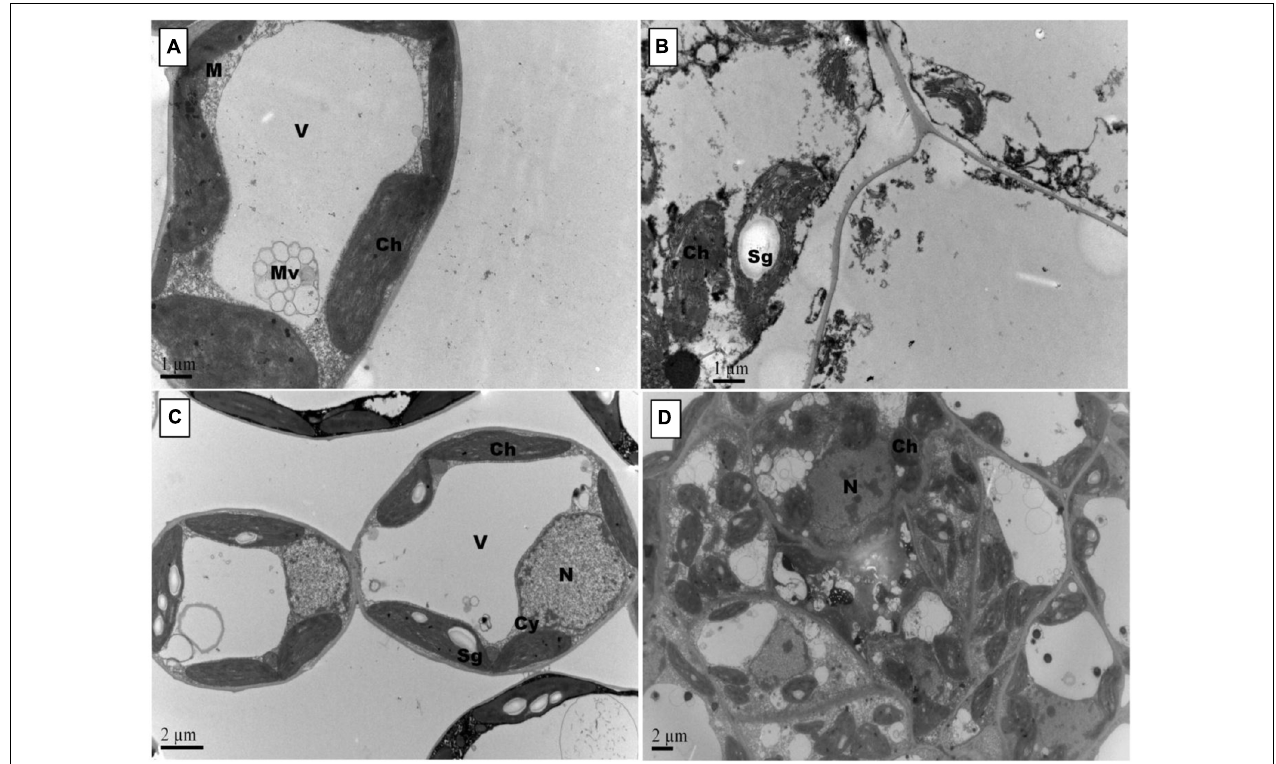
FIGURE 5 | Effects of Pb and GSH on ultrastructure of upland cotton median leaves Transmission electron micrographs represent leaf cell morphology of control (A) , 500 µ M Pb (B) , 50 µ M GSH (C) and 500 µ M Pb + 50 µ M GSH (D) in cotton seedlings. Control cells (A) , contained large central vacuole (V), well developed chloroplasts and rounded mitochondria (M). After Pb exposure (B) , chloroplasts were highly dilated and plasma membrane detached from cell walls. GSH-treated leaf cells (C) demonstrated large chloroplasts and clearly located nucleus. In GSH + Pb group (D) , chloroplasts were dilated but increased in number.